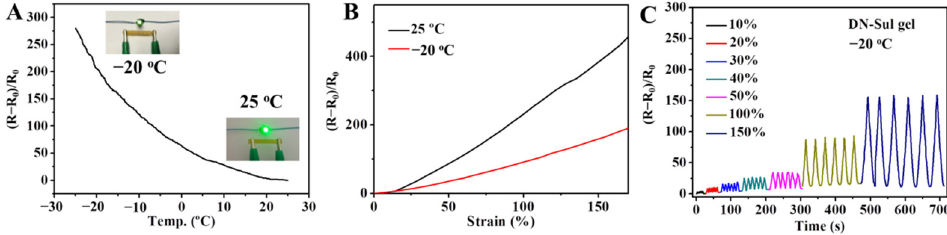
Figure 10. ( A ) The relative resistance change of the DN hydrogel with the temperature decreasing from 25 ◦ C to − 20 ◦ C (the resistance at 25 ◦ C was defined as R 0 ). Inset pictures showed the bulb light’s from 25 °C to − 20 °C (the resistance at 25 °C was defined as R 0 ). Inset pictures showed the bulb variation in the circuit connected by the DN hydrogel at 25 ◦ C and − 20 ◦ C. ( B ) The performance light’s variation in the circuit connected by the DN hydrogel at 25 °C and − 20 °C. ( B ) The perfor- comparison of the DN hydrogel sensor at 25 ◦ C and − 20 ◦ C. ( C ) Real-time relative resistance-change mance comparison of the DN hydrogel sensor at 25 °C and − 20 °C. ( C ) Real-time relative re- curves on multiple tensile strains at − 20 ◦ sistance-change curves on multiple tensile strains at − 20 °C.